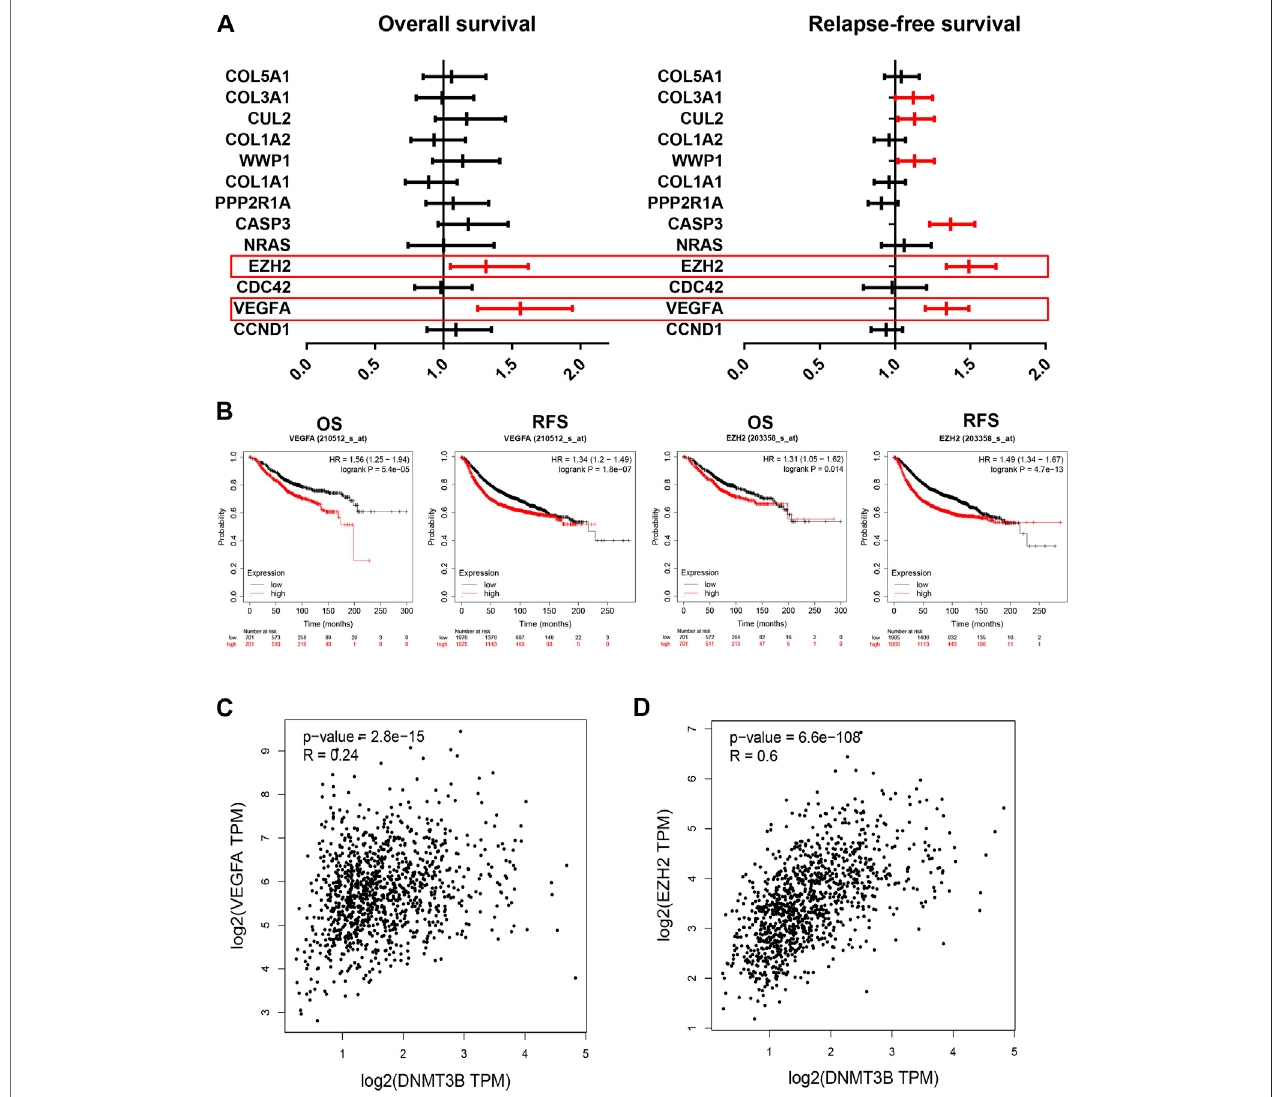
FIGURE 7 | Identi fi cation of VEGFA and EZH2 as the most potential downstream target genes in the established DNMT3B-associated miRNA – mRNA network. Overallsurvival (A) andrelapse-freesurvival (B) analysesfor10genesofinterestinbreastcancer. (B) PrognosticvaluesofVEGFAandEZH2inbreastcancerdetermined by the Kaplan – Meier plotter. DNMT3B expression was signi fi cantly positively correlated with the expression of VEGFA (C) or EZH2 (D) in breast cancer assessed by GEPIA.